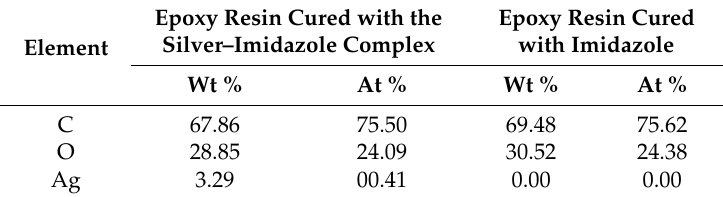
Figure 3. Thermogravimetric analysis thermograms of imidazole, silver–imidazole complex (AgI), and silver acetate (AgAc).